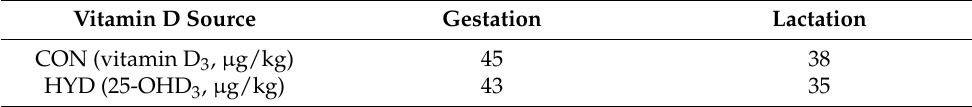
Table 3. Analyzed mean feed concentrations of vitamin D 3 and 25-OHD 3 ( µ